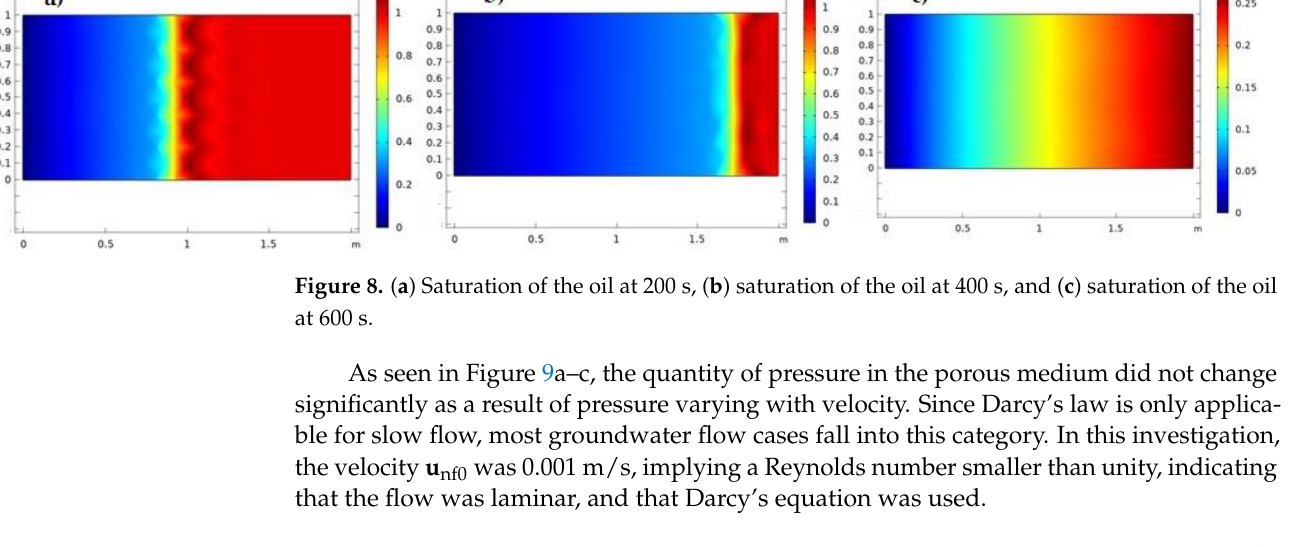
Figure 8. ( a ) Saturation of the oil at 200 s, ( b ) saturation of the oil at 400 s, and ( c ) saturation of the oil at 600 s.